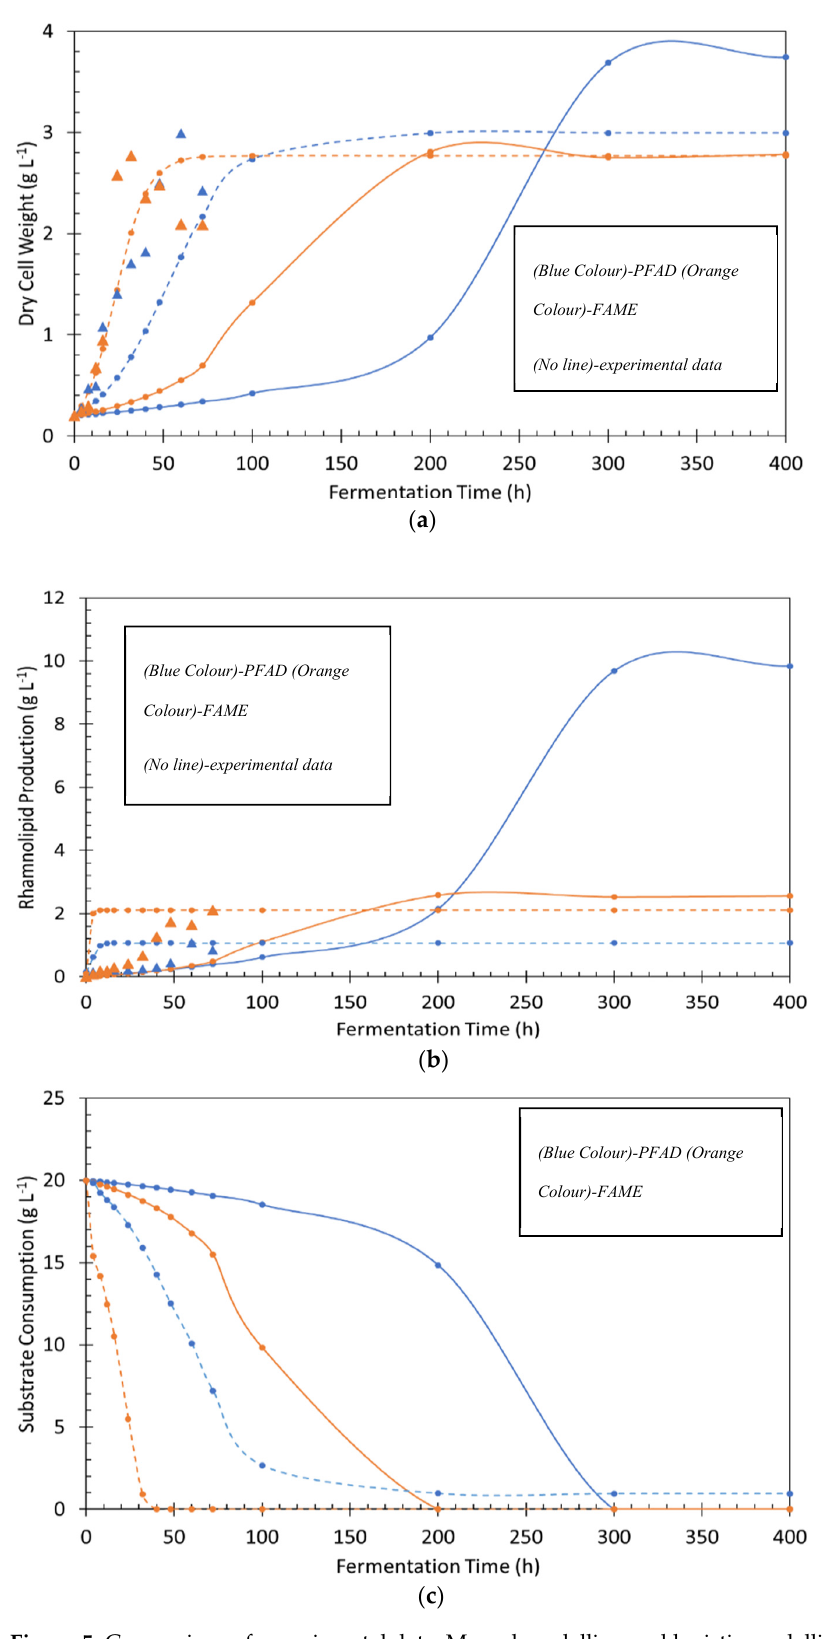
Figure 5. Comparison of experimental data, Monod modelling and logistic modelling for PFAD and FAME as carbon sources: ( a ) dry cell weight, ( b ) rhamnolipid production, and ( c ) substrate con- sumption.